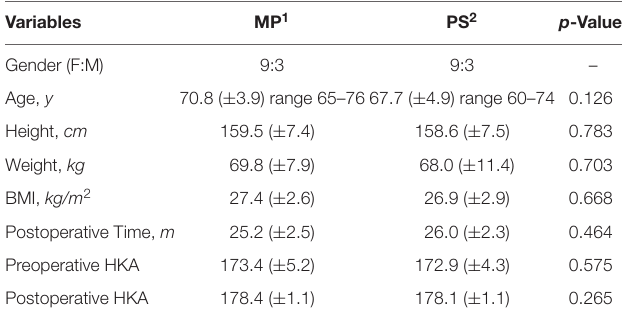
TABLE 1 | Patient demographics and postoperative